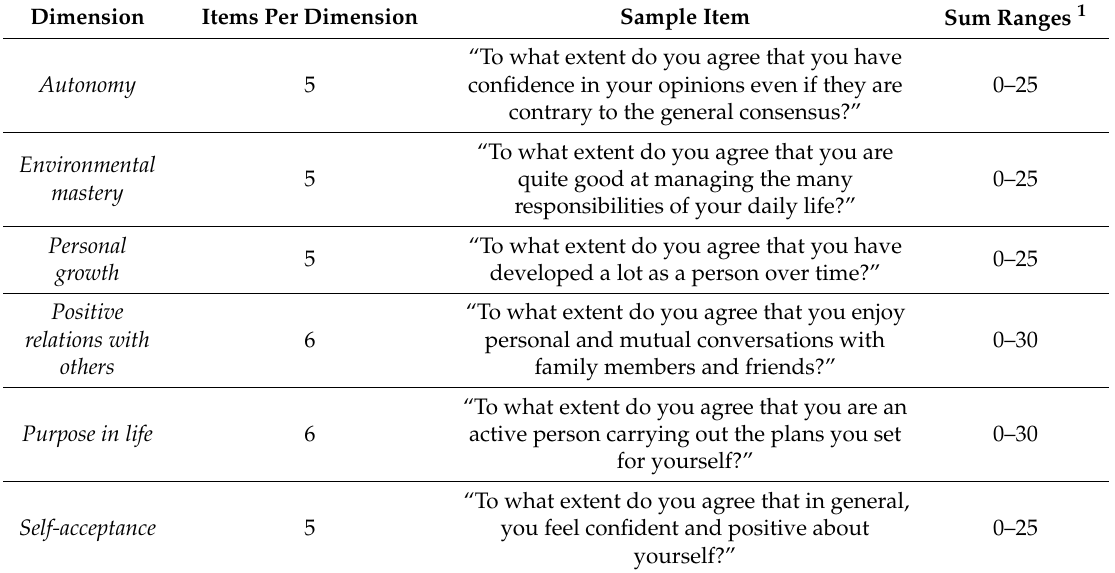
Table 1. Measurement of psychological